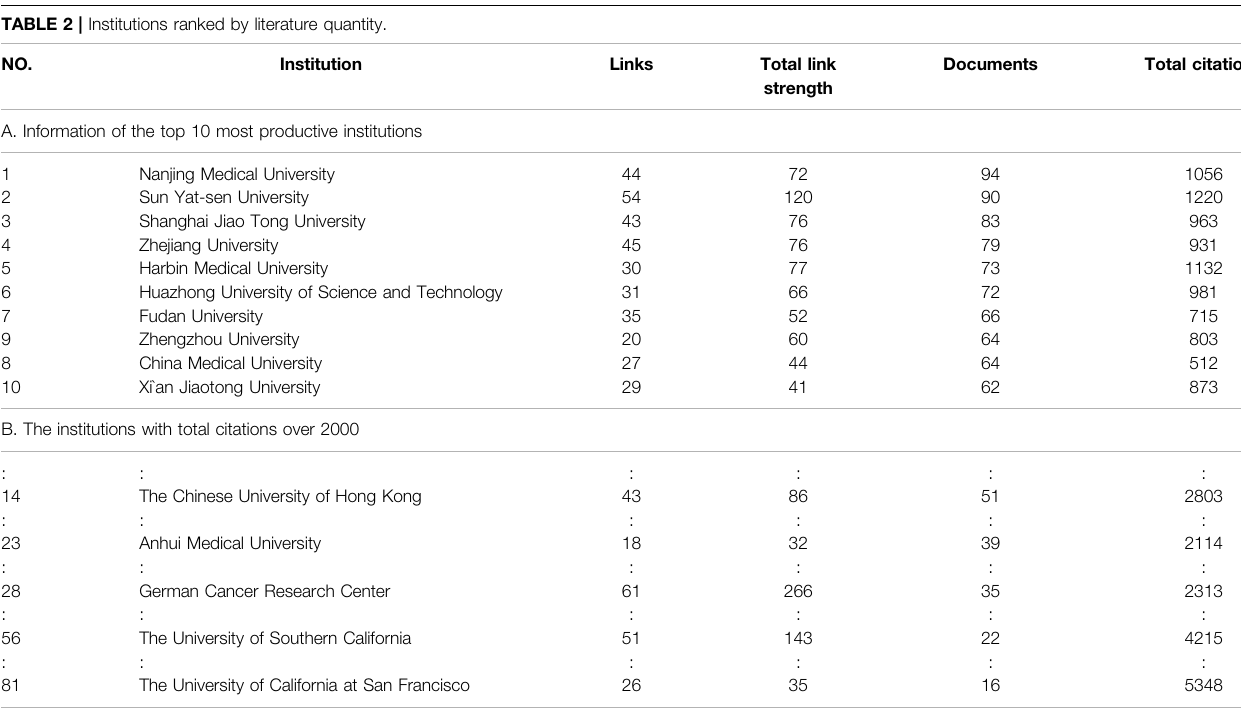
TABLE 2 | Institutions ranked by literature quantity. NO. Institution Links Total link